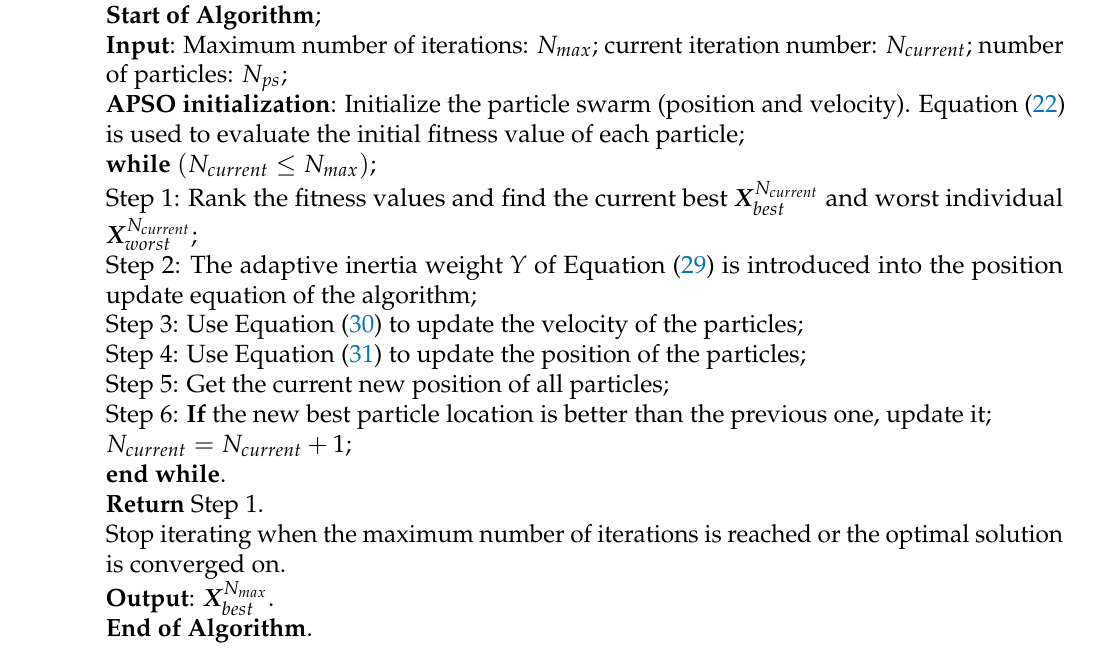
Algorithm 1 Pseudocode of particle swarm optimization algorithm with adaptive inertia